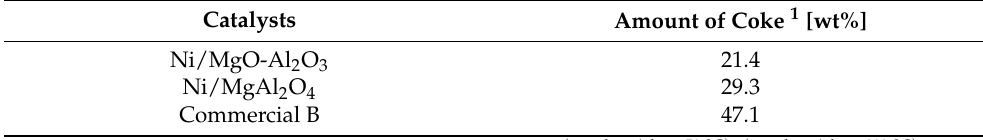
Figure 7. TG profiles of spent catalysts under air (reaction conditions: Temp. = 600 °C, CH 4 /CO 2 /N 2 = 1/1/1, GHSV = 144,000 mL/g cat ∙h, TOS = 20 h). Table 3. Amount of coke over Ni catalysts from TG profiles (reaction conditions: Temp. = 600 °C, CH 4 /CO 2 /N 2 = 1/1/1, GHSV = 144,000 mL/g cat ∙h, TOS = 20 h).